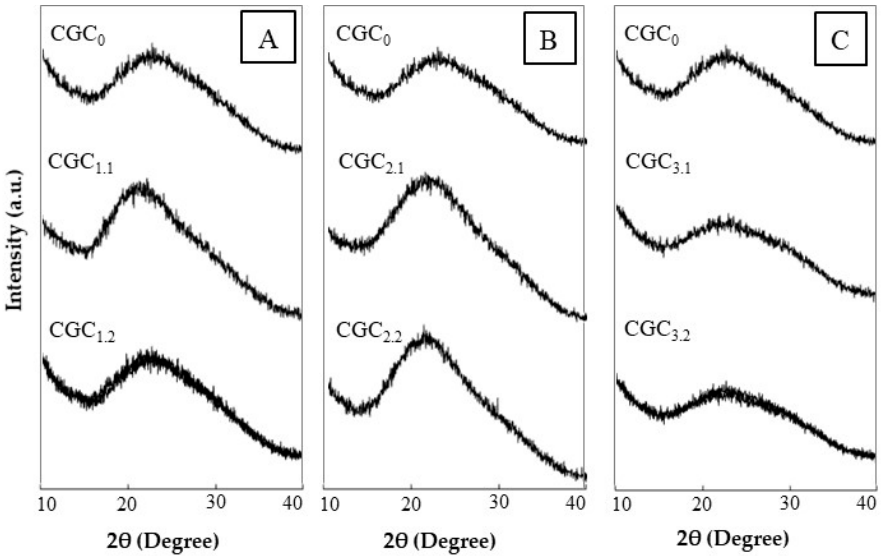
Figure 5. X-ray diffraction profiles of CGC 0 and the polymer regenerated from the soluble fractions of CGC in: ( A ) solvent systems 1 (CGC 1.1 and CGC 1.2 ), ( B ) solvent systems 2 (CGC 2.1 and CGC 2.2 ) and